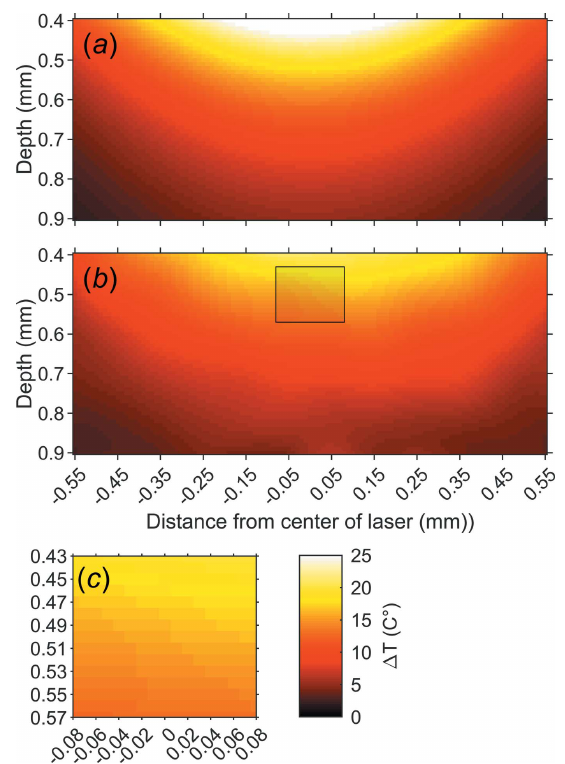
Figure 4 Temperature-dependent difference scattering signal. ( a ) The decay back to the base temperature, following a single 2 ms laser pulse. ( b ) The T-jump is maintained by supplying a train of secondary pulses, in this case 50 s-long pulses are triggered at 90 Hz over 3 s following the initial T-jump.